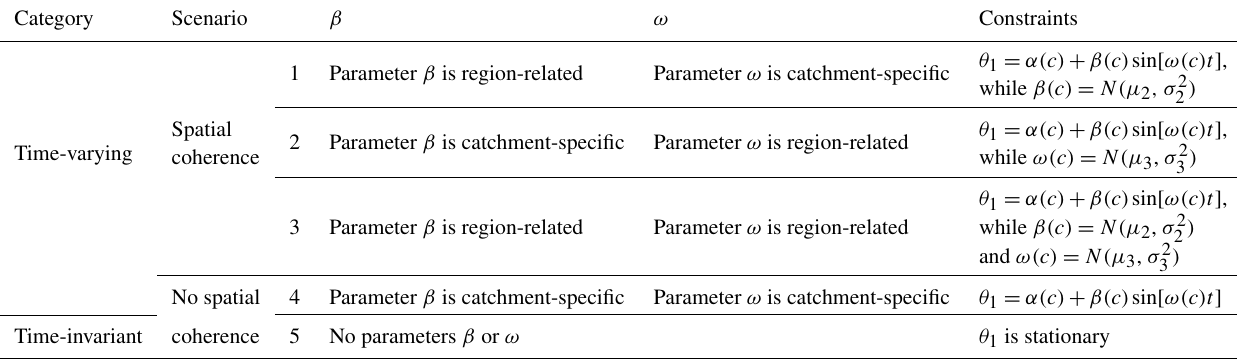
Table 1. Different spatial coherence scenarios for amplitude β and frequency ω in the time-varying functional form of model parameter θ 1 . To explore the performance of spatial coherence within the time-varying function, different levels of spatial coherence for amplitude β and frequency ω were assumed for the first three scenarios; in contrast, no spatial coherence is assumed in scenario 4, and a temporally stable θ 1 is assumed in scenario